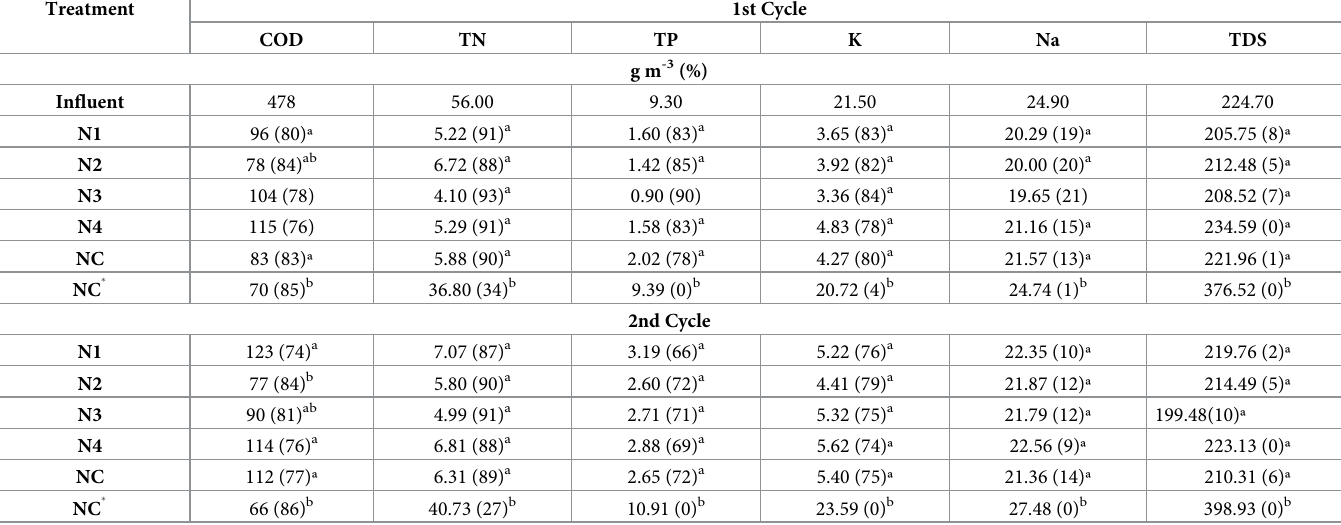
Table 10. Average concentrations and efficiency removal of pollutants from the synthetic municipal wastewater effluent and Dunnet’s test for comparison of aver- ages of controls with doses of GA 3 . Treatment